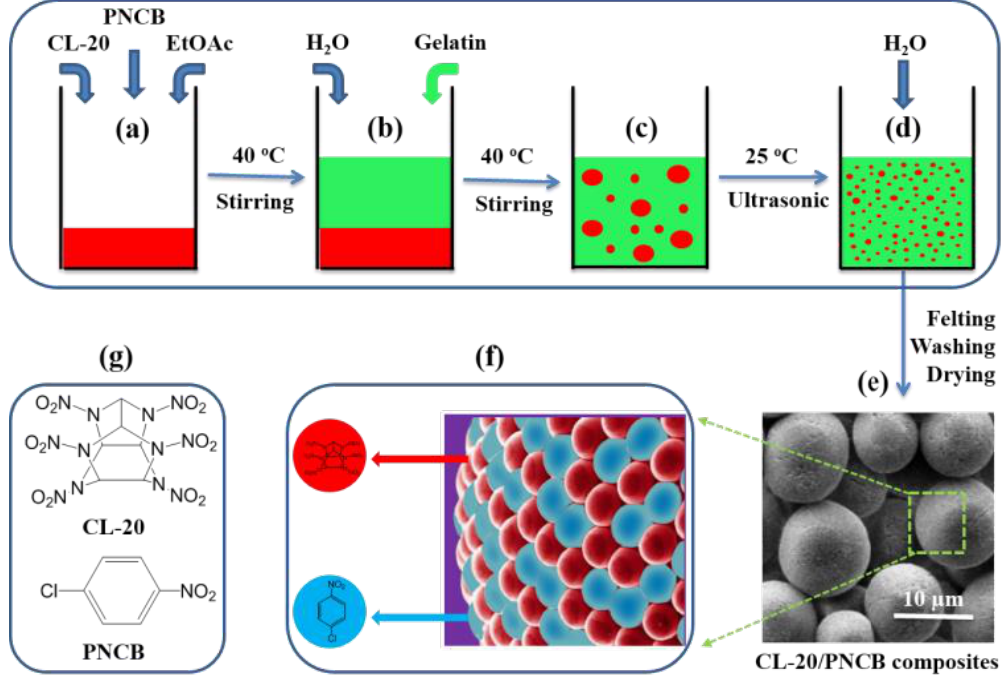
Figure 1. ( a – d ) Schematic showing preparation of the spherical CL-20/PNCB composite via the ultrasonic-assisted emulsion (UAE) method. ( e , f ) SEM and model images of the target composite. ( g ) Chemical structures of 2,4,6,8,10,12-hexanitro-2,4,6,8,10,12-hexaazaisowurtzitane (CL-20) and P-nitrochlorobenzene (PNCB).